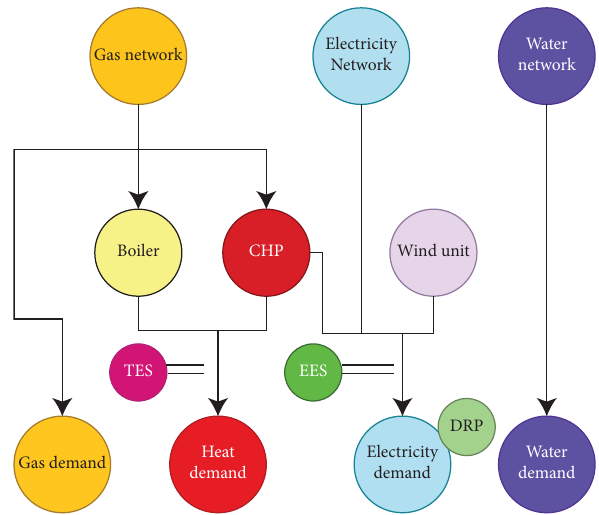
Figure 1: Te studied energy hub